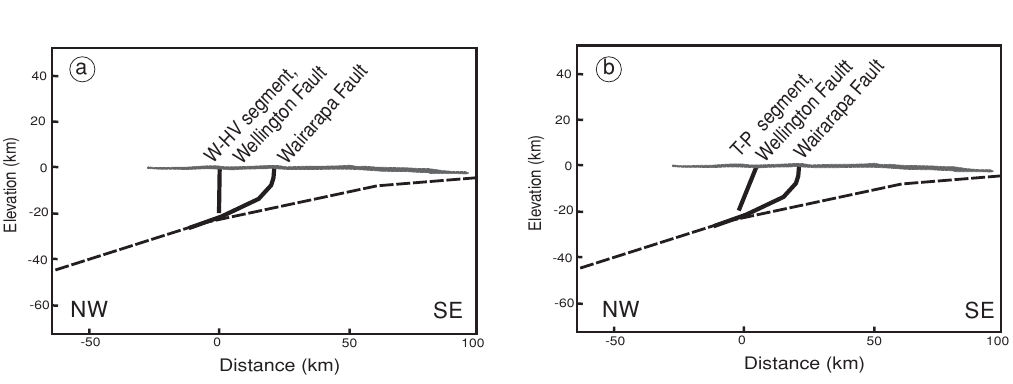
Fig. 2a,b. A listric Wairarapa Fault Model with a NW dip (modified from Darby and Beanland, 1992). The deepest segment is taken to extend tangentially from the modeled subduction interface at a depth of 25 km. A vertical dip for the W-H segment (a) and a 70 ° dip to the northwest for the T-P segment (b) are assumed (Russ J. Van Dissen, personal communication). Depth to bottom of the Wellington Fault or seismogenic thickness is assigned as 20